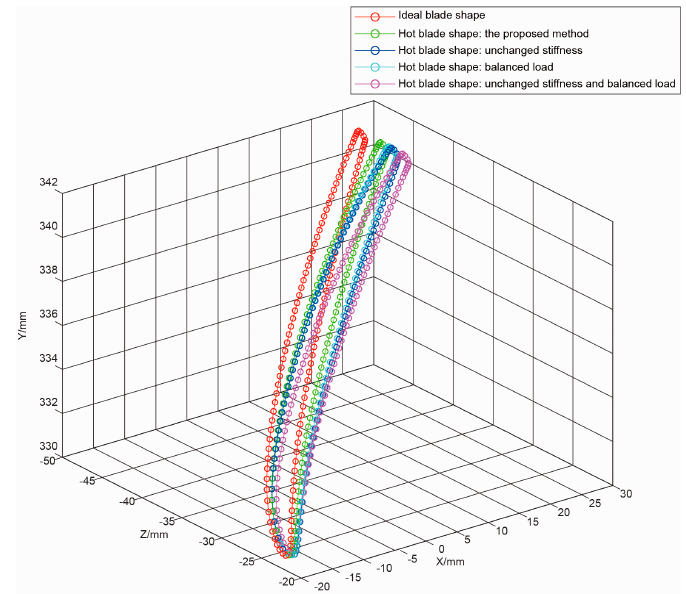
Figure 6. Coordinate changes of the contour node at the blade top.